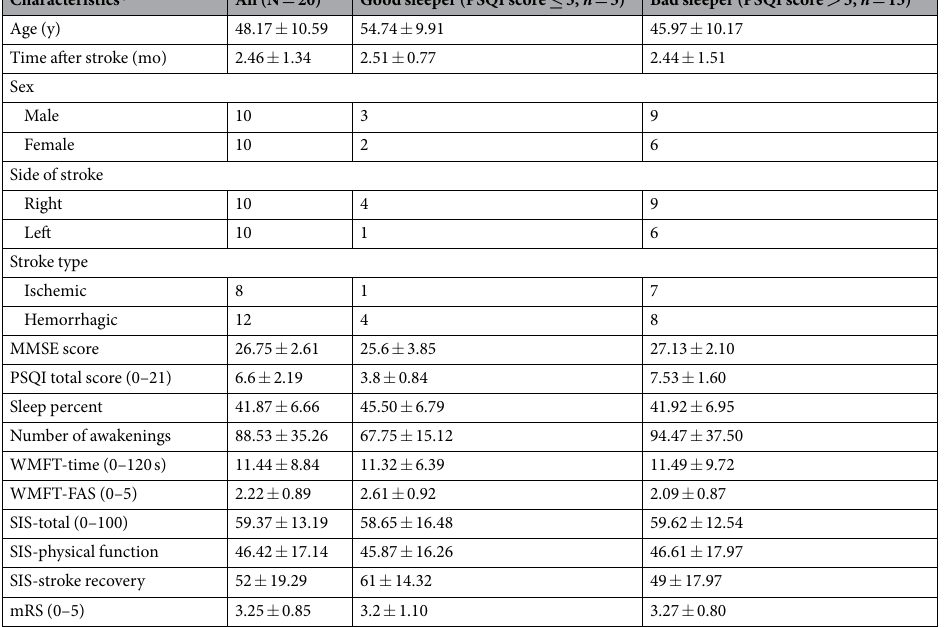
Table 1. Demographics and baseline clinical characteristics of the participants. MMSE = Mini-Mental State Examination; PSQI = Pittsburg Sleep Quality Index; WMFT-time = performance time of the Wolf Motor Function Test; WMFT-FAS = functional ability scale of the Wolf Motor Function Test; SIS = Stroke Impact Scale; mRS = modified Rankin Scale. * Continuous data are presented as the mean ± SD; categorical data are presented as indicated.